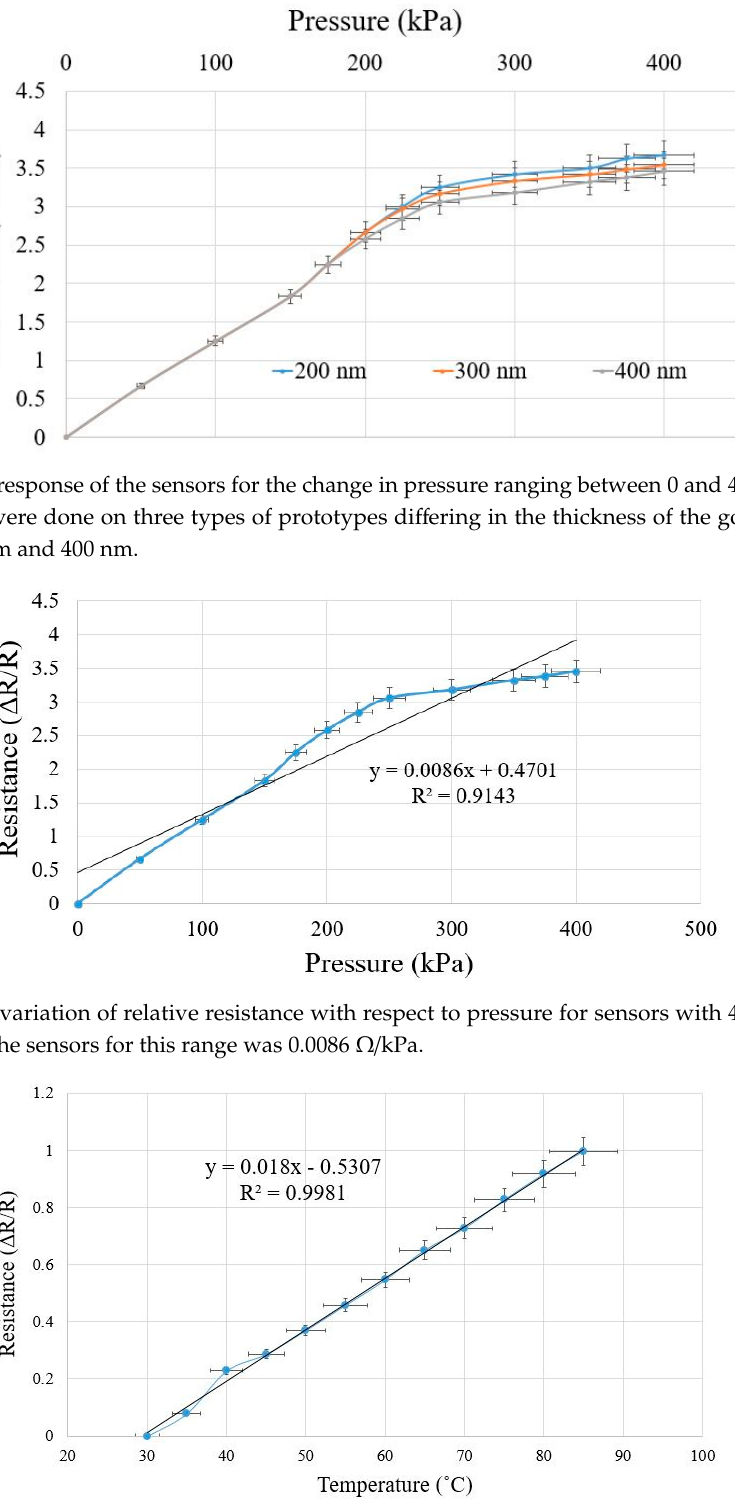
Figure 9. The response of the sensors for the change in temperature ranging between 30 ˚ C and 85 ˚ C.